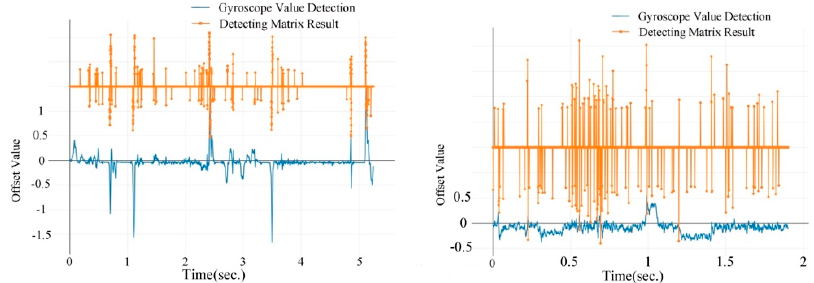
Figure 12. Real-time lane changes recorded by gyroscopes on urban road ( left ) and highway ( right ).